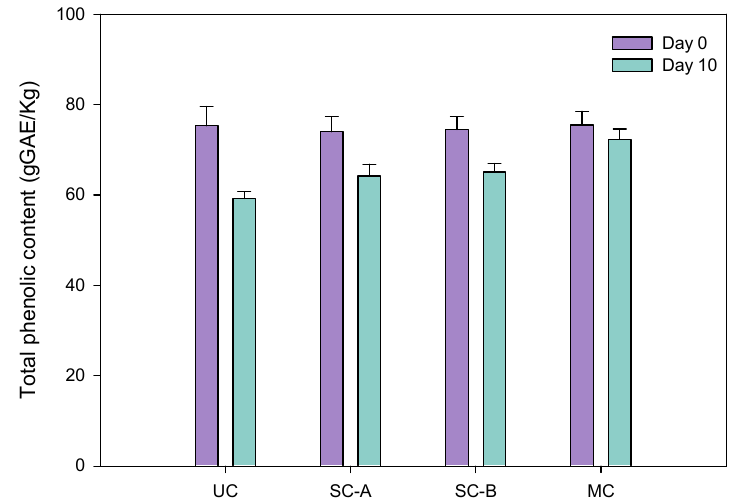
Figure 4. Coatings’ effect on cherimoya phenolic content over time. Total phenolic content was detected in uncoated, single-layer, and multilayer coating on cherimoya at 0 and 10 days of their storage. N = 3; data shown are mean ± standard deviation.